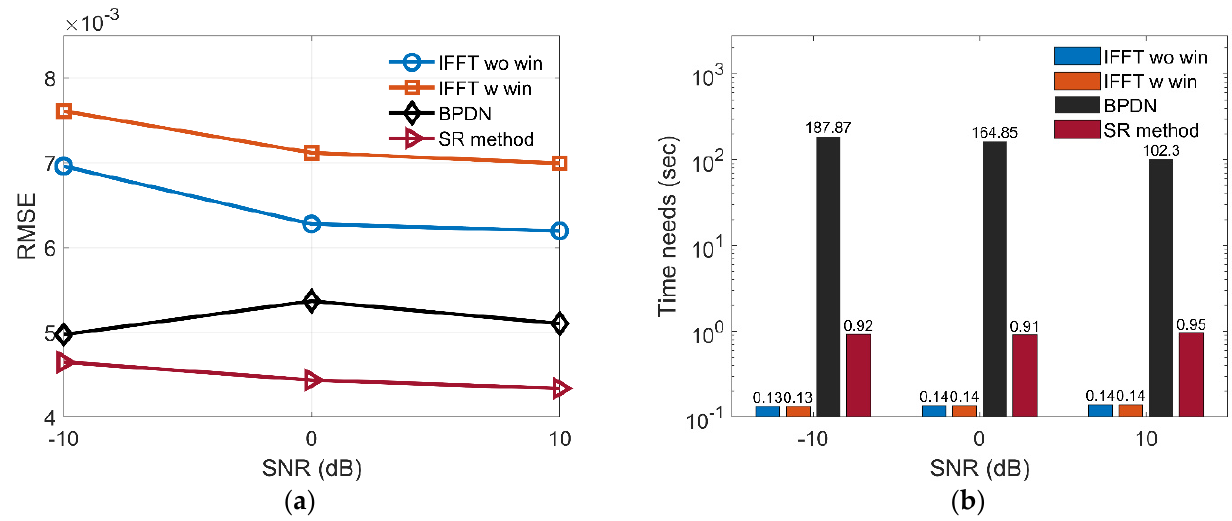
Figure 12. Comparison of ( a ) RMSE and ( b ) Average time needs among four different methods.